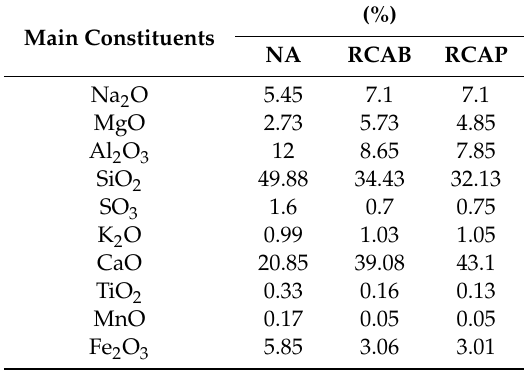
Table 6. XRF chemical compositions of NA, RCAP, and RCAB.